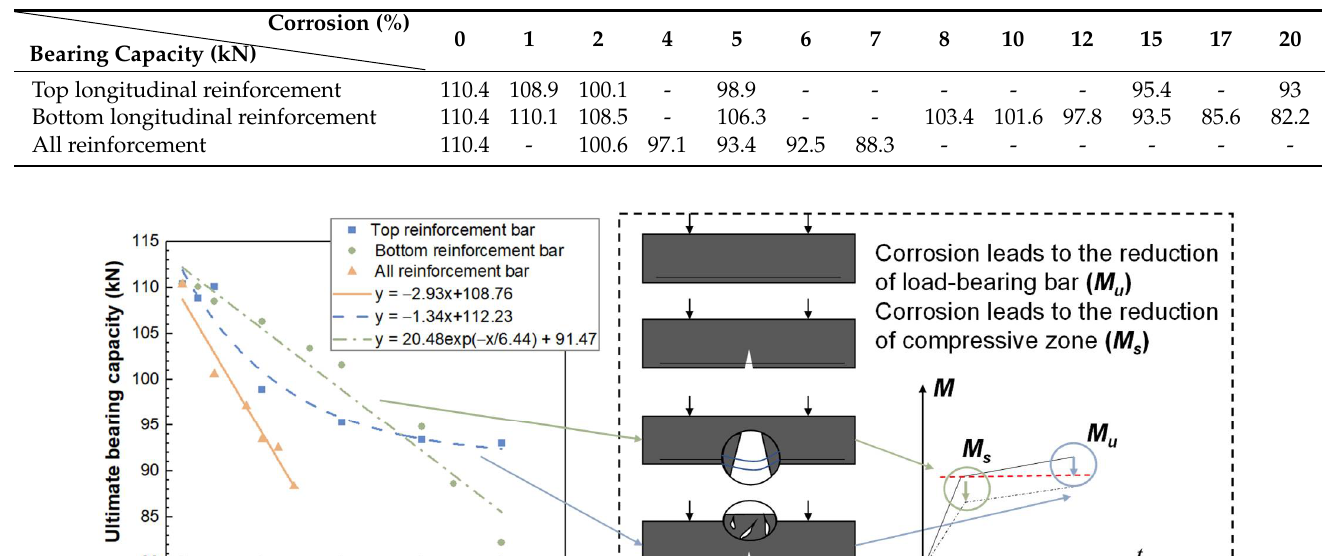
Table 2. Deterioration of ultimate bearing capacity for different rust patterns.